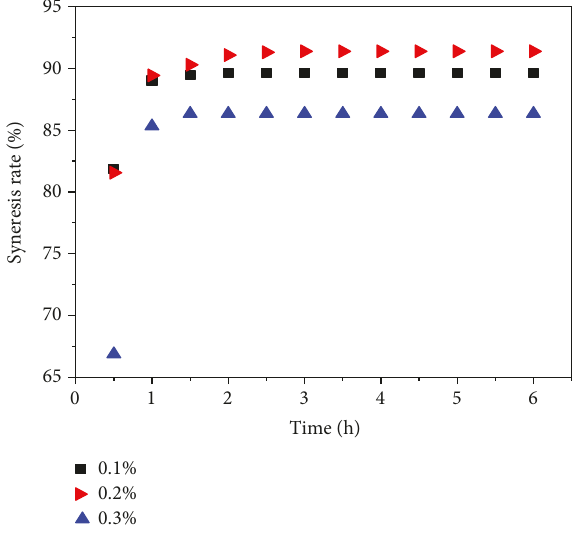
Figure 5: The syneresis rate of emulsion under di ff erent content of surfactant.